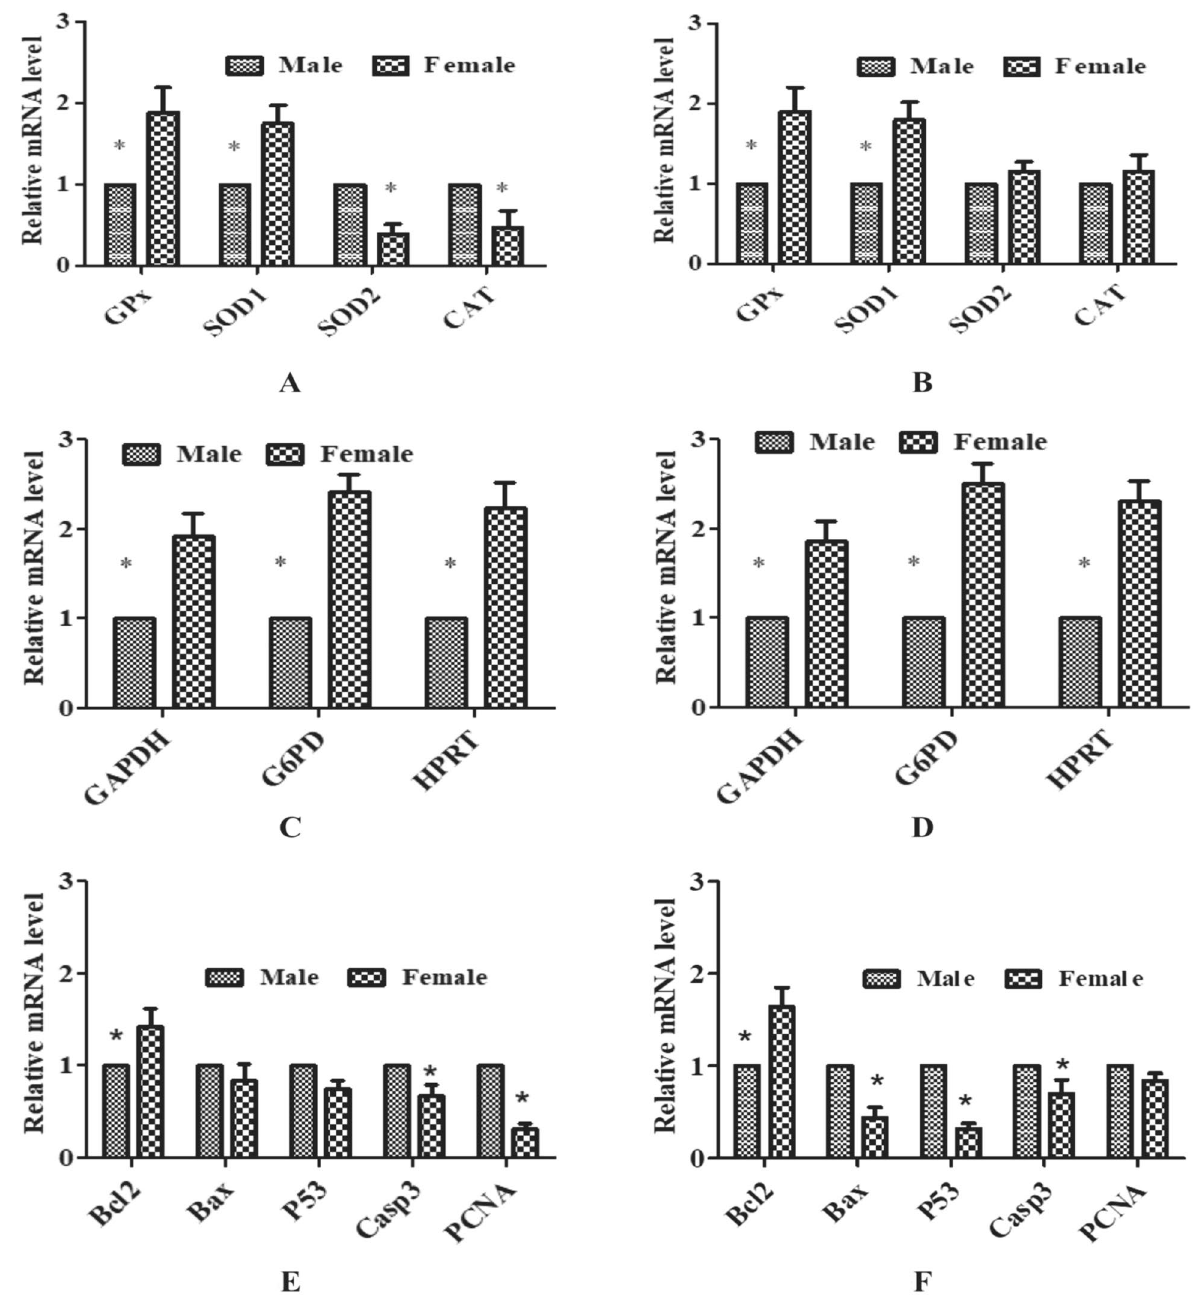
Figure 6. Sex-specific differences in relative expression level of developmental genes in ovine embryos at different oxidative status. ( A ) Antioxidant genes at high oxidative status. ( B ) Antioxidant genes at low oxidative status. ( C ) Glucose metabolism genes at high oxidative status. ( D ) Glucose metabolism genes at low oxidative status. ( E ) Apoptotic genes at high oxidative status. ( F ) Apoptotic genes at low oxidative status. *Significant difference between male and female at P <